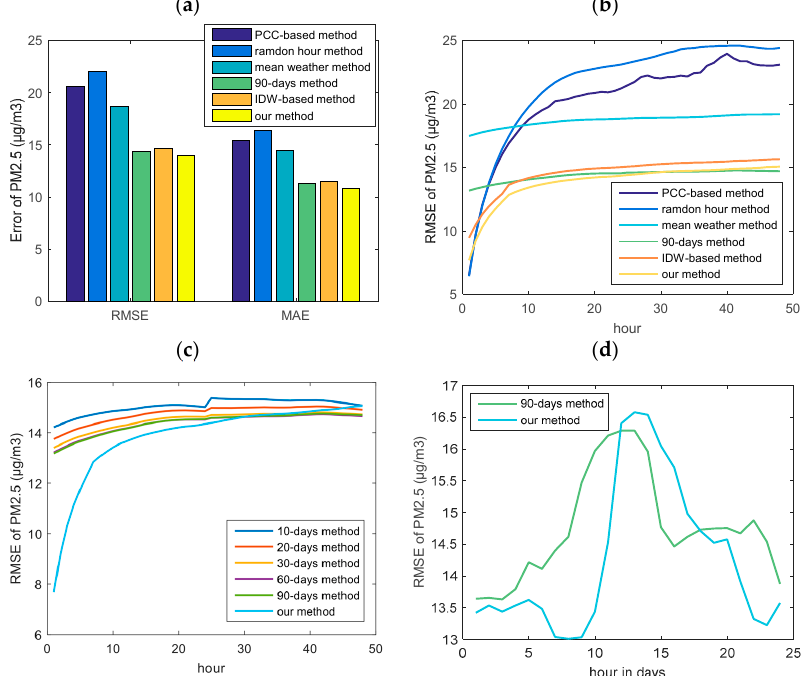
Figure 14. Evaluation of the PM2.5 forecast error for ( a ) different methods in RMSE and MAE, ( b ) different methods in various hours, ( c ) different days methods in various hours, and ( d ) different methods in various hours in days.